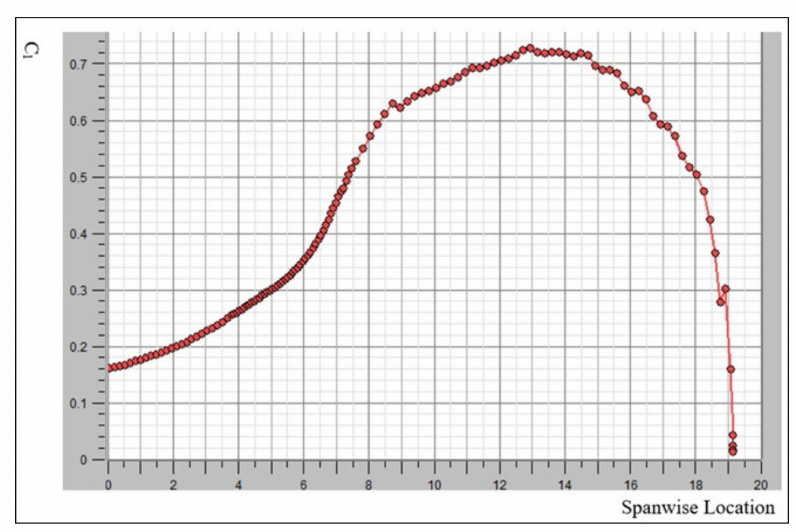
Figure 3. Local lift coe ffi cient distribution across the wingspan.